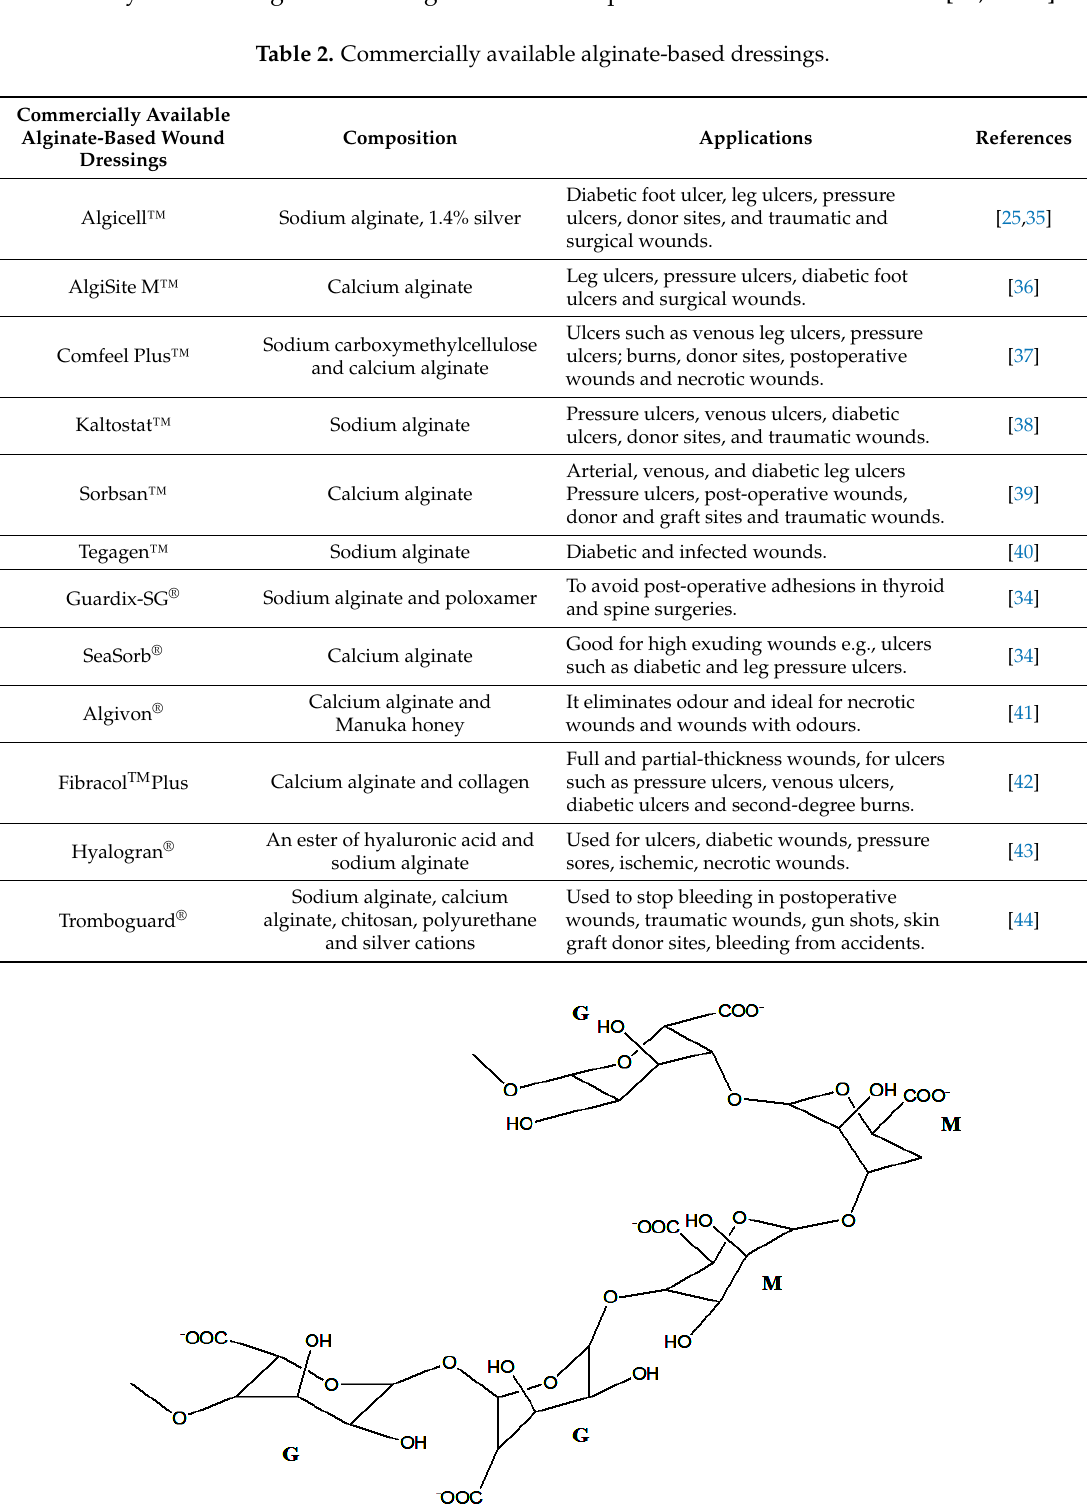
Figure 3. Structure of α - L -guluronic and β - D -mannuronic alginate residues.